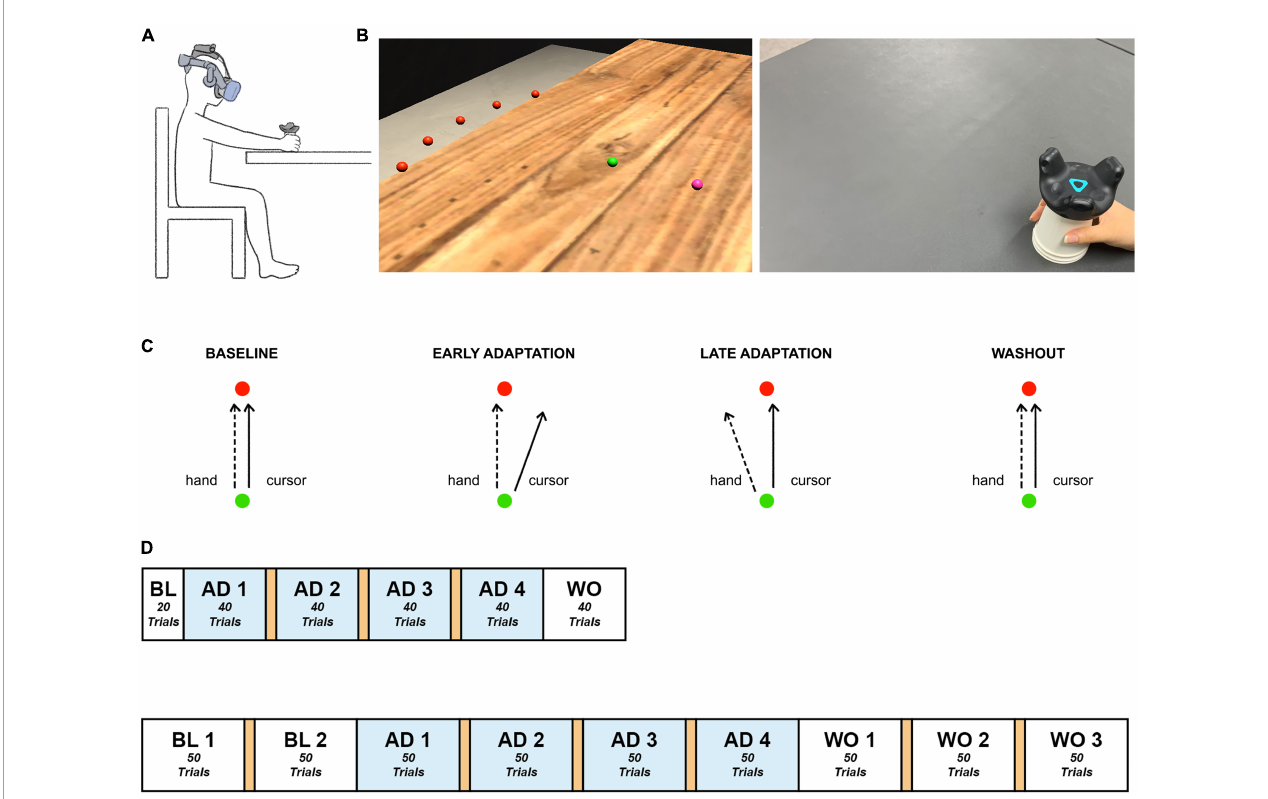
FIGURE1 Experimental paradigm. (A) Experimental setup. Participants sat in front of a table, experienced the VR environment through an HMD, and moved the tracker-attached cup using their right hand. (B) Experimental environment. Participants made goal-directed reaching movements in the virtual reality environment. Left: The established HMD-VR experimental environment. The hand position, starting point, and target were displayed as spheres with a radius of 0.5 cm, distinguished by color (pink, green, and red, respectively), and located 12 cm above the table, which was the height of the cup. The five targets appeared at once in the practice session. Each trial of the experimental task contained one target. Each target (red) was spaced 15 ◦ apart on an invisible sector around the starting point (green) with a radius of 20 cm. Right: The real-world view. Participants moved a VR tracker attached to a cup for each reaching movement. (C) Experimental task. Participants moved a tracker from the starting point (green) to a target (red). Baseline: The hand trajectory and cursor trajectory were identical. Adaptation: The cursor was 20 ◦ clockwise rotated from the actual hand trajectory, and the participants learned to move their hand to compensate for the applied rotation. Washout: The visual rotation was removed, and the hand trajectory went back to the baseline state. (D) Experimental task flow. Top: Short task group. Bottom: Long task group. The experiment consisted of baseline, adaptation, and washout sessions. A 1-min break between blocks is indicated in orange. BL, baseline; AD, adaptation; WO,